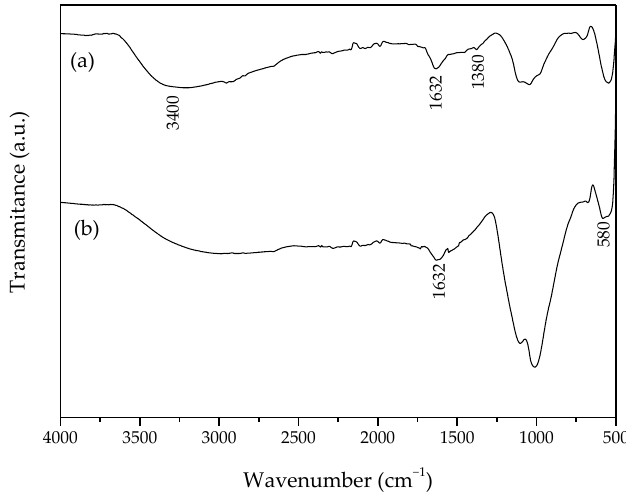
Figure 9. FTIR analysis of initial ( a ) and final ( b ) goethite